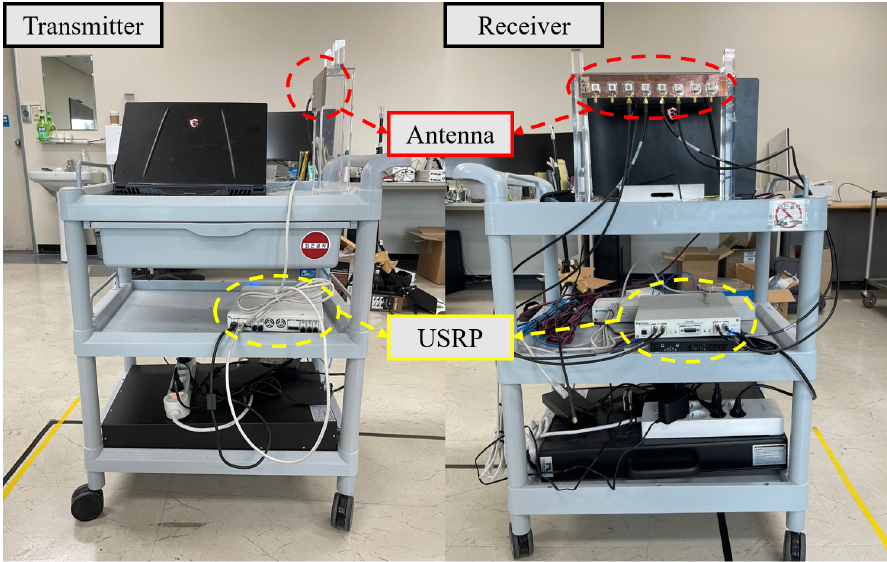
Figure 2. A picture of transmitter and receiver used for the